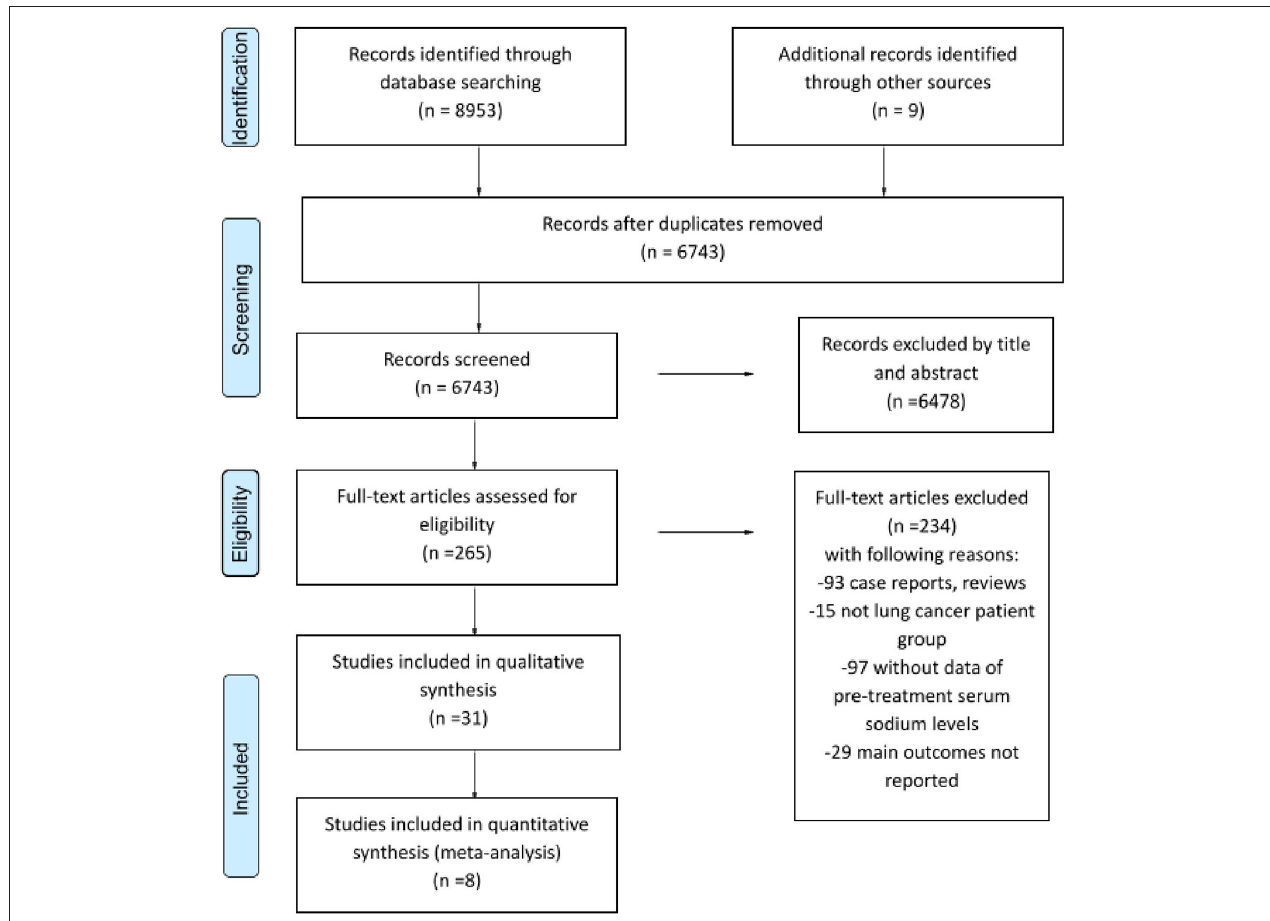
FIGURE 1 | A preferred reporting items for systematic reviews and meta-analyses (PRISMA) flow diagram representing the process of study search and